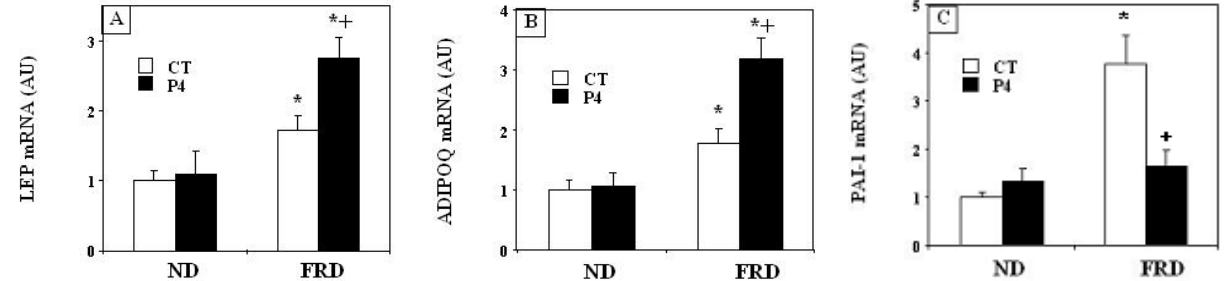
PAI-1 ( C ) measured (by q-PCR) in different experimental groups. Values are expressed as the mean ± SEM ( n = 4 pads per